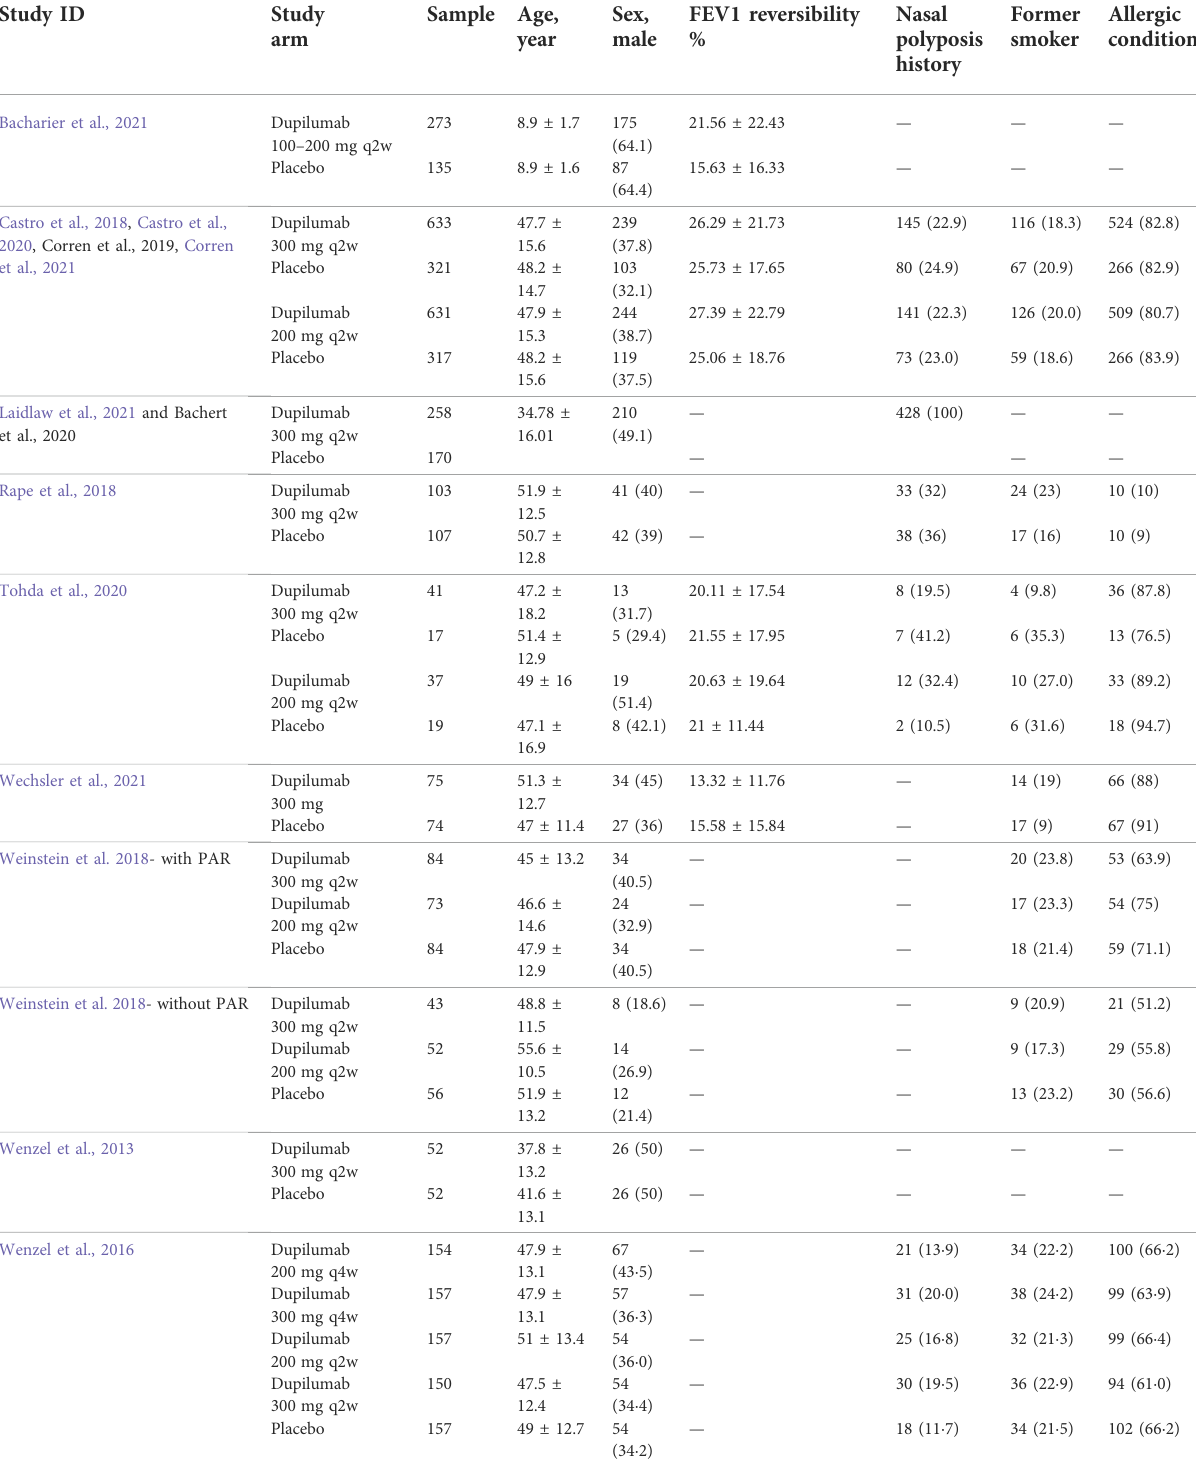
TABLE 2 Baseline characteristics of the study